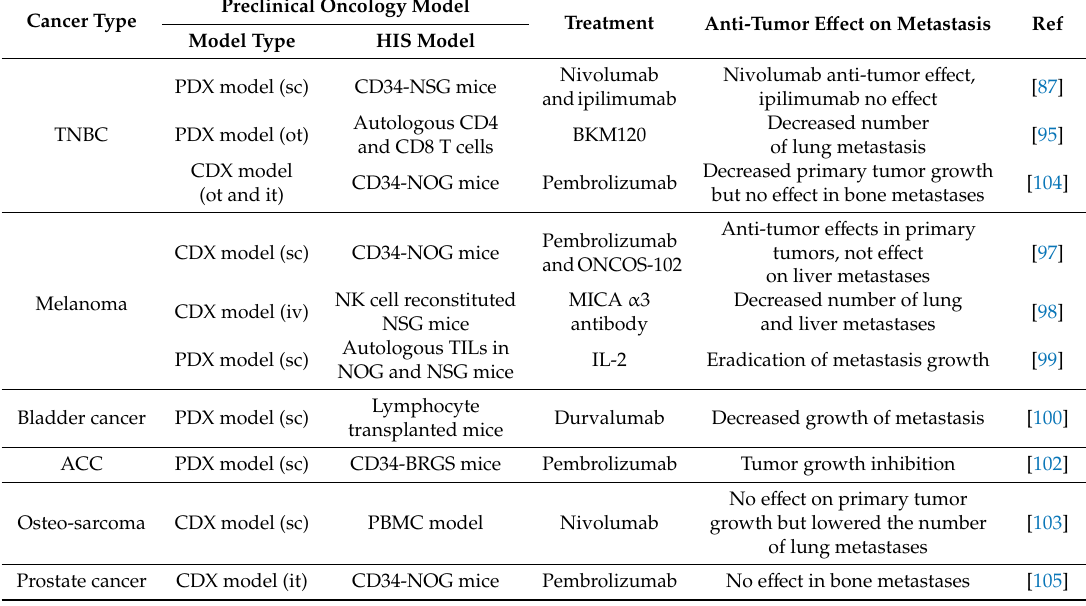
Table 1. Summary of anti-tumor e ff ects of immunotherapies on metastasis in di ff erent humanized mouse